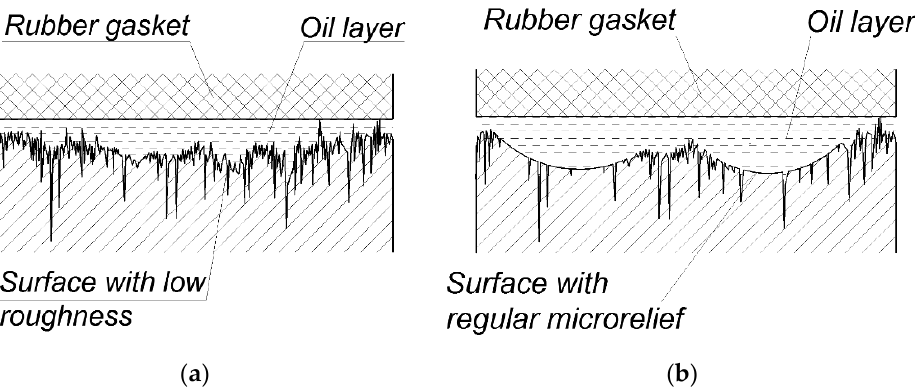
Figure 7. Surface interaction schemes: ( а ) surface with low roughness and micro defects; ( b ) surfaces with regular micro- relief.